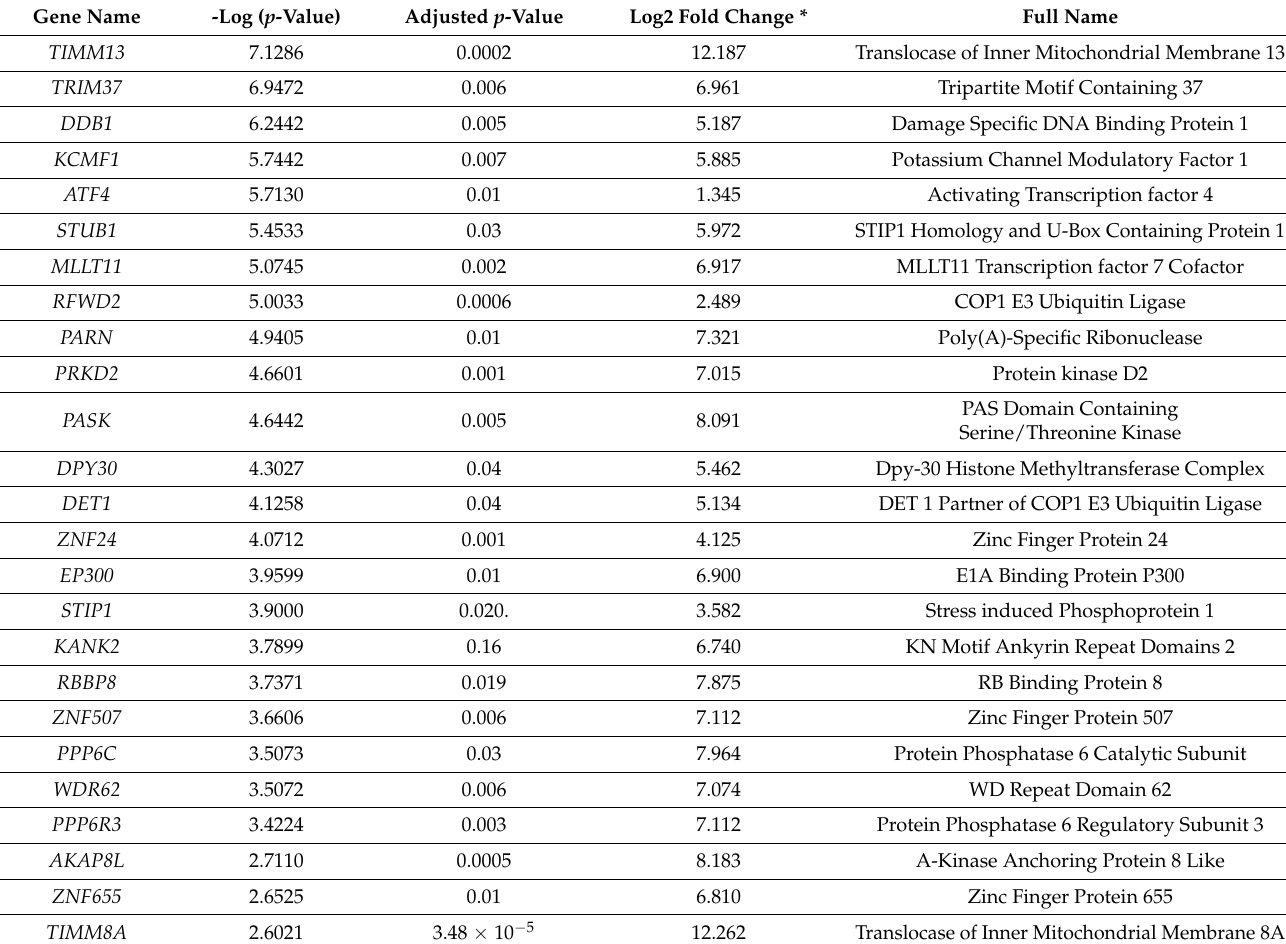
Table 3. Top 25 TRIB3 interacting partners in HEK293T cells based on p